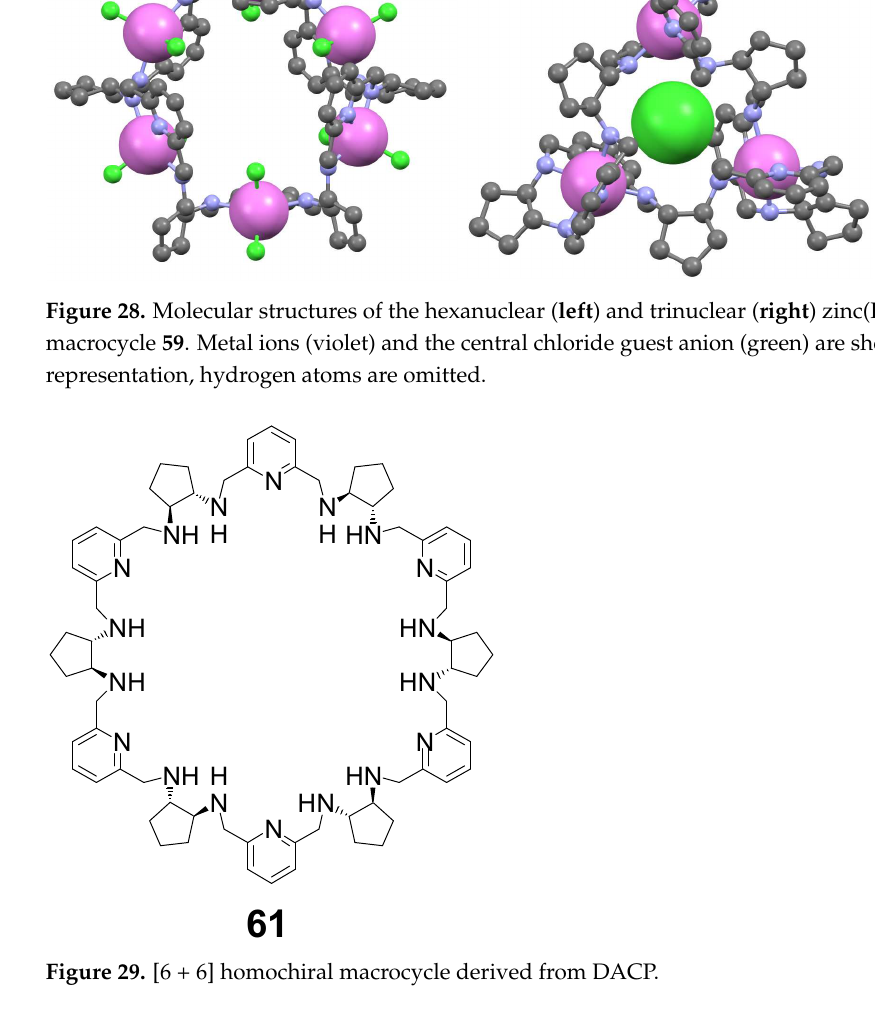
Figure 29. [6 + 6] homochiral macrocycle derived from DACP.